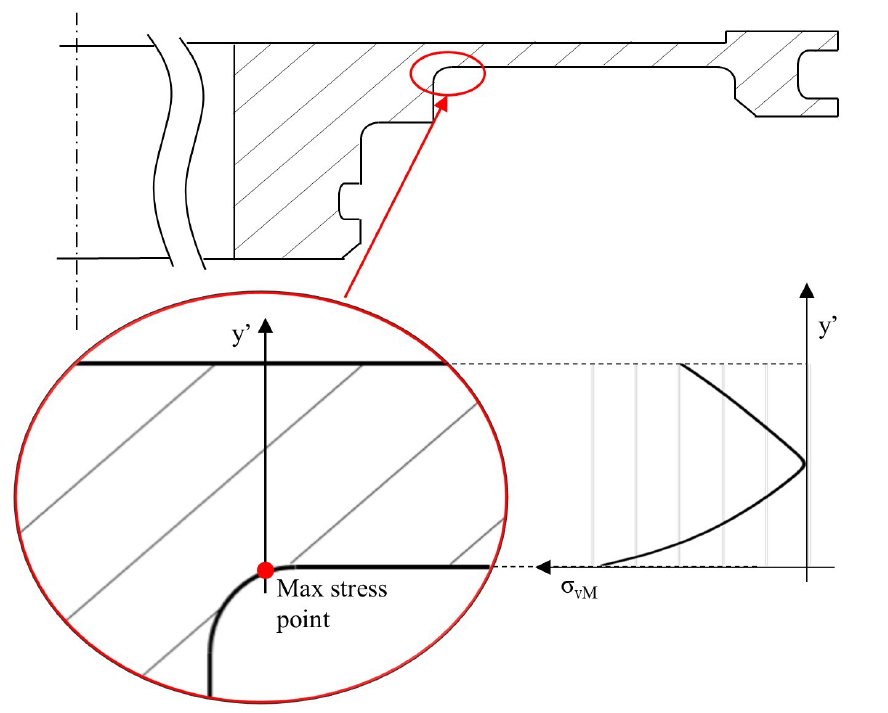
Figure 9. Schematic representation of stress gradient beneath the maximum stress